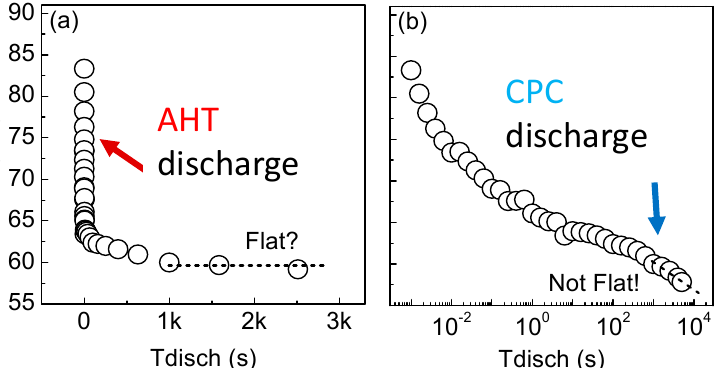
Figure 24. Discharge against linear ( a ) and logarithmic ( b ) time. The AHT can be neutralized rapidly due to its lower energy level. This is followed by a gradual discharge of CPC [53].